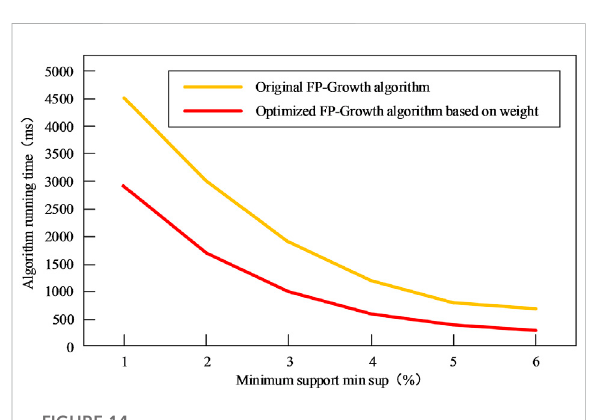
FIGURE 14 Variation of algorithm running time with minimum support.